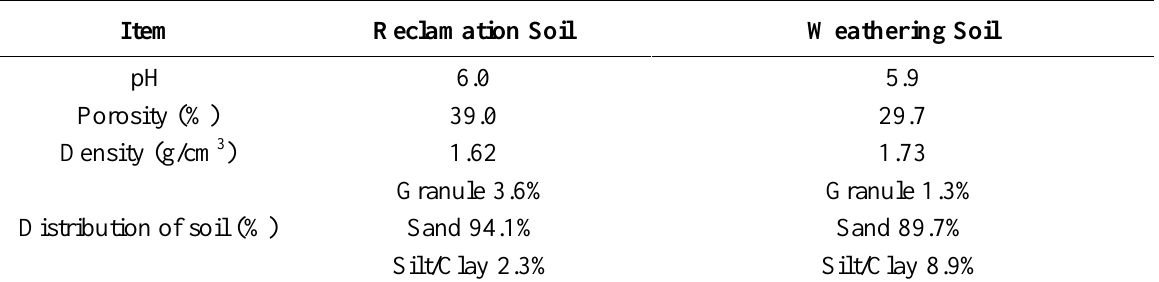
Table 1. Summary of soil properties in this